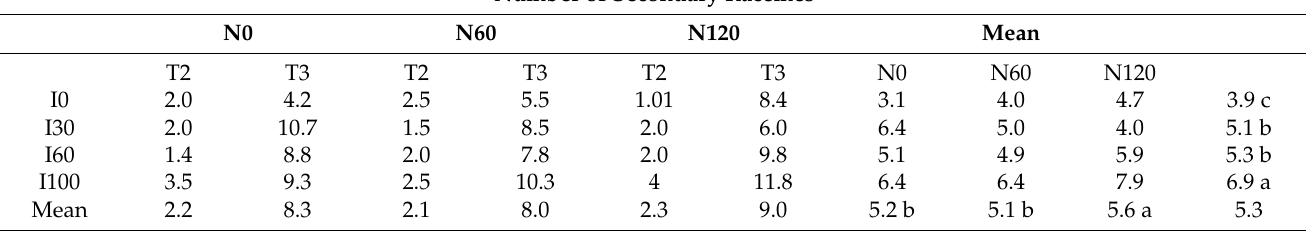
Table 1. Number of secondary racemes in relation to irrigation (I0, I30, I60, and I00 = 0, 30, 60, and 100% ETm, respectively) and N level (N0, N60, and N120 = 0, 60, and 120 kg ha − 1 N) of secondary racemes in 2021 and 2022 (T2 and T3, respectively). In the mean columns, the average values of all N levels (last row) and the average values of all irrigation levels (last column) followed by the same letter did not significantly differ at p ≤